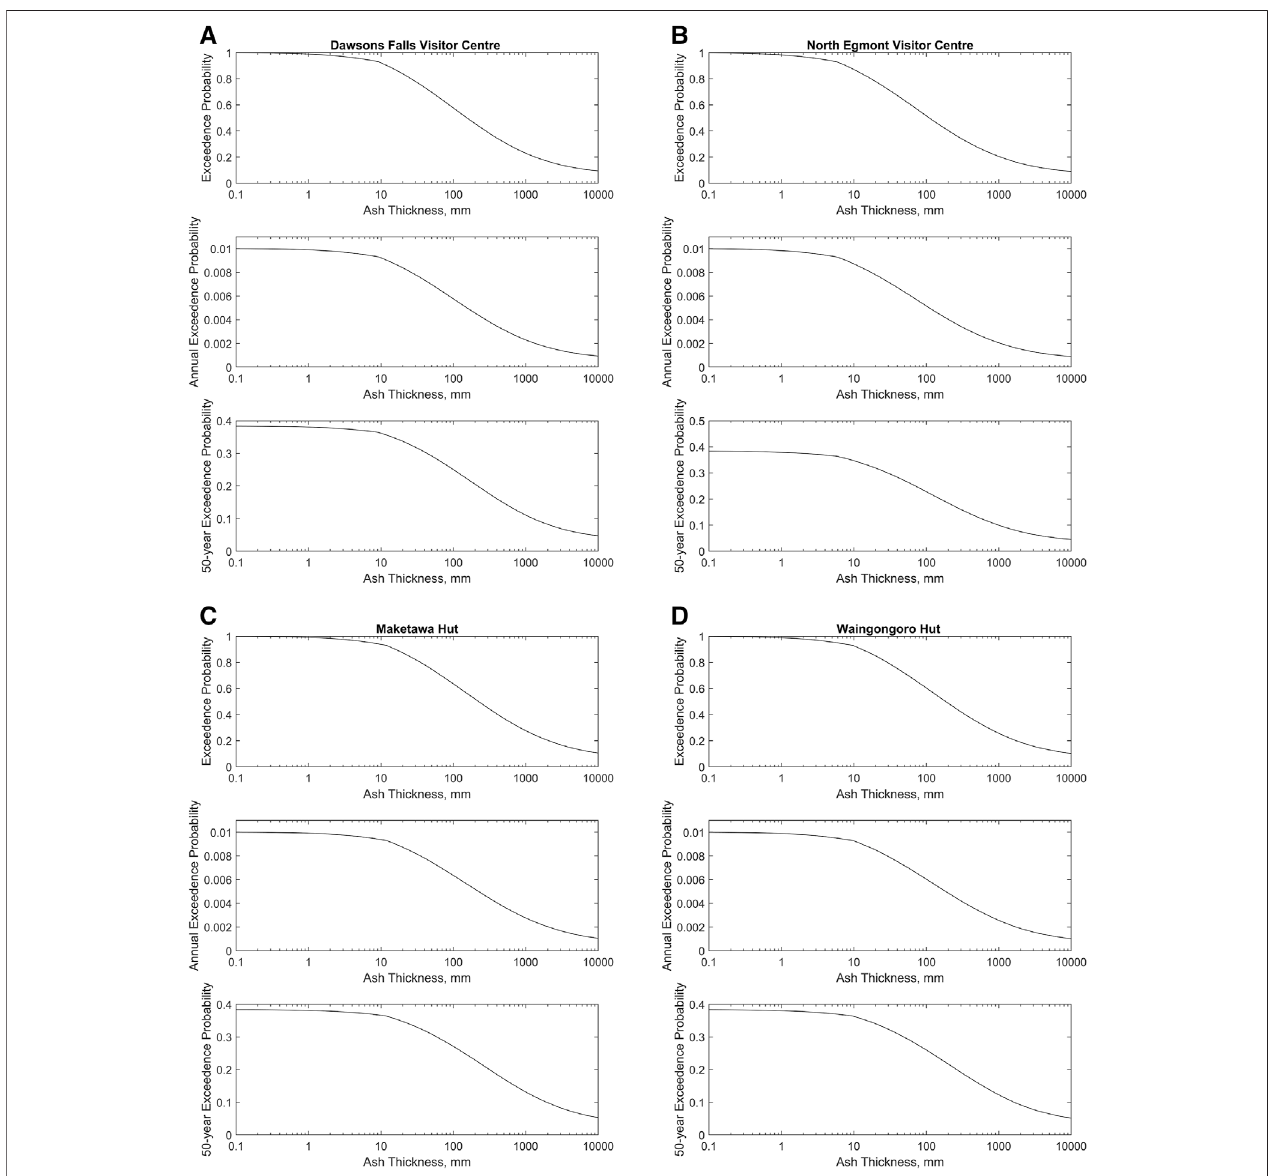
FIGURE 4 | Ashfall thickness exceedance probability at (A) Dawsons Falls Visitor Centre, (B) North Egmont Visitor Centre, (C) Maketawa Hut, (D) Waingongoro Hut. Top chart shows exceedance probability given an eruption, middle shows Annual exceedance probability, bottom shows 50 years exceedance probability.